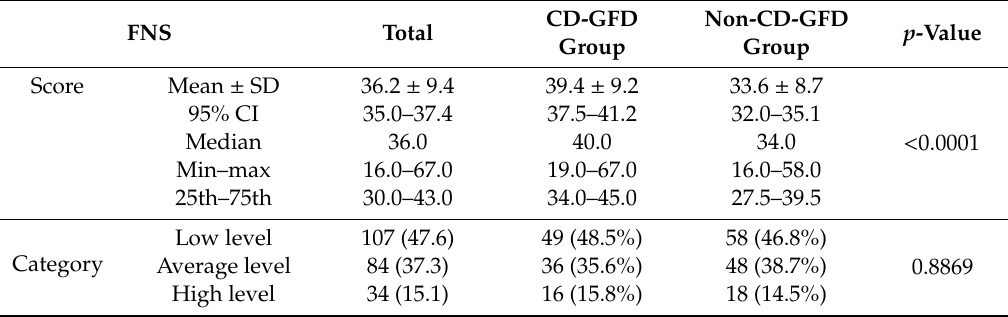
Table 2. Food Neophobia Scale (FNS) scores of the respondents in sub-groups of CD-GFD and non-CD-GFD